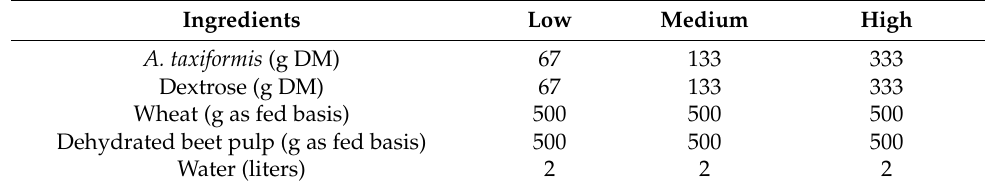
Table 1. Amount and composition of the seaweed mix fed daily to dairy cattle at low, medium, or high levels.